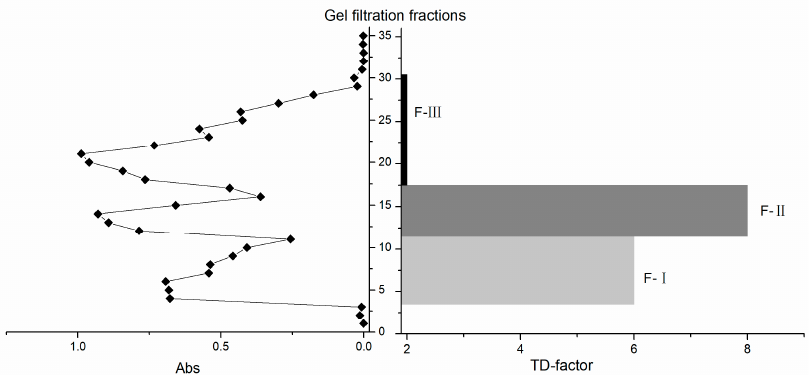
Figure 1. Gel chromatography and taste dilution (TD)-factors of kokumi-flavored green tea samples (Huiming green tea).